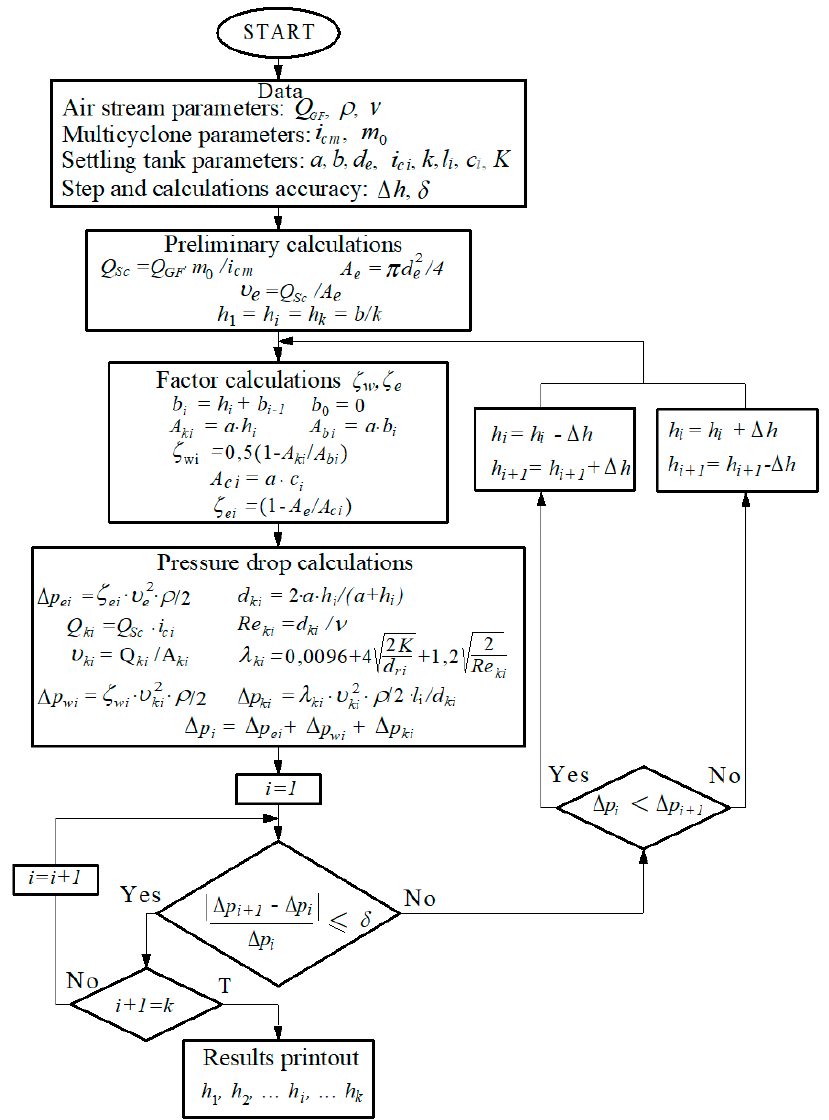
Figure 15. Algorithm for calculating channel heights in the suction chamber of the dust collector segment.